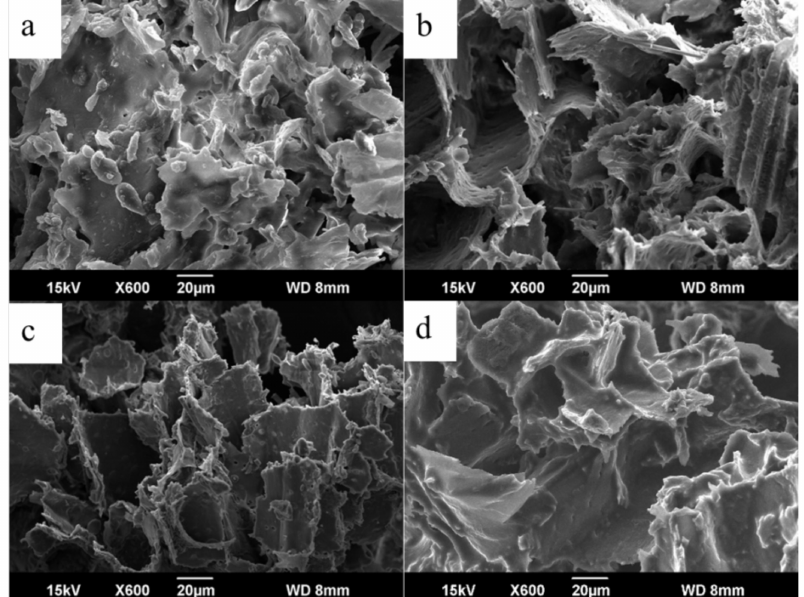
Figure 5. The field emission scanning electron microscope images of DNR powder: ( a ) before ultrasonic extraction and after ultrasonic extraction in ( b ) water, ( c ) methanol, and ( d ) the selected NADES